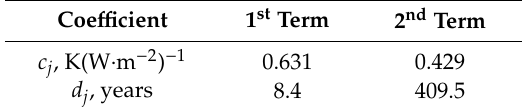
Table 3. Values of the climate sensitivity and response time coe ffi cients